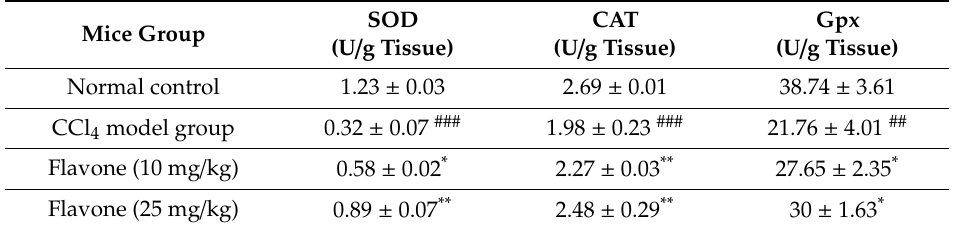
Table 1. Effect of the flavone on the levels of SOD, CAT, and Gpx in liver tissue homogenates. SOD CAT Normal control Mice Group (U/g Tissue)